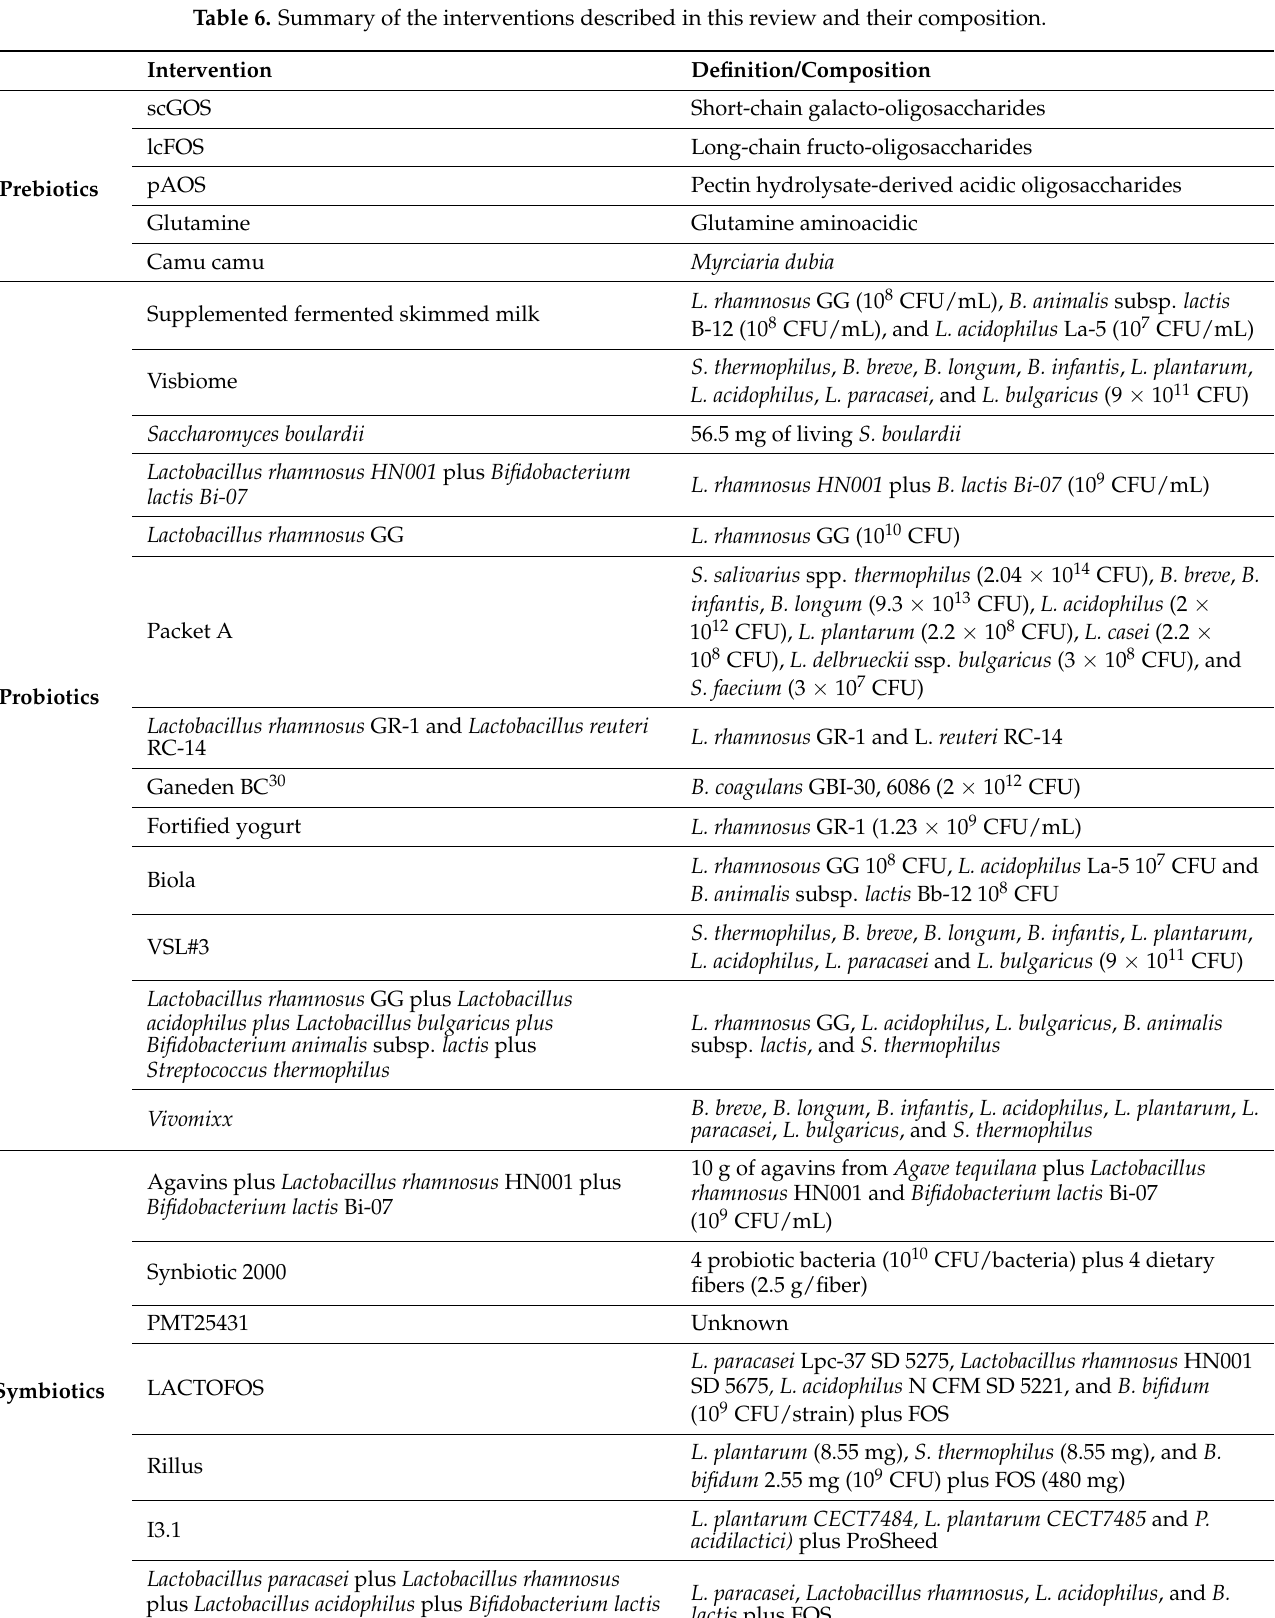
Table 6. Summary of the interventions described in this review and their